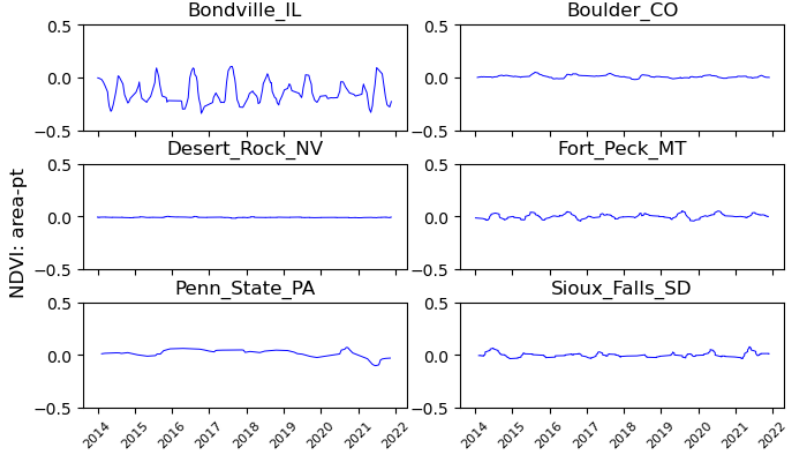
Figure 13. The heterogeneity analysis of SURFRAD stations over NDVI variable.